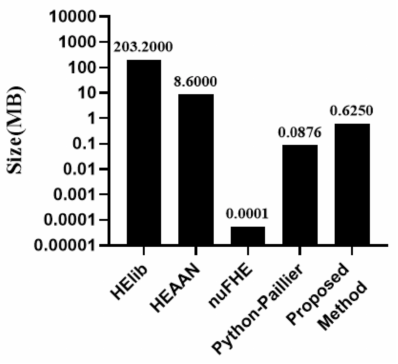
Figure 14. Size comparison on the resultant ciphertext for a search query.